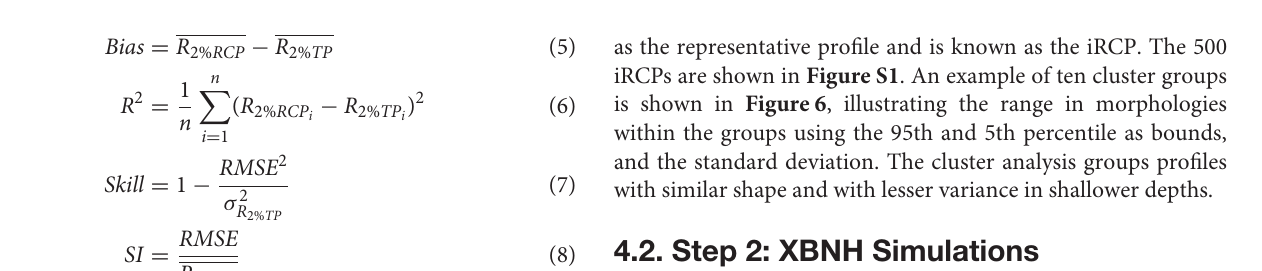
FIGURE 6 | Example of 10 cluster groups used to form the initial representative cluster profiles (iRCPs). The x-axis represents the cross-shore width and the y-axis the elevation. The green area defines the standard deviation within the cluster and the blue dashed lines the 5th and 95th percentiles. The number of reef topobathymetric cross-shore profiles within the cluster is shown in the title of each